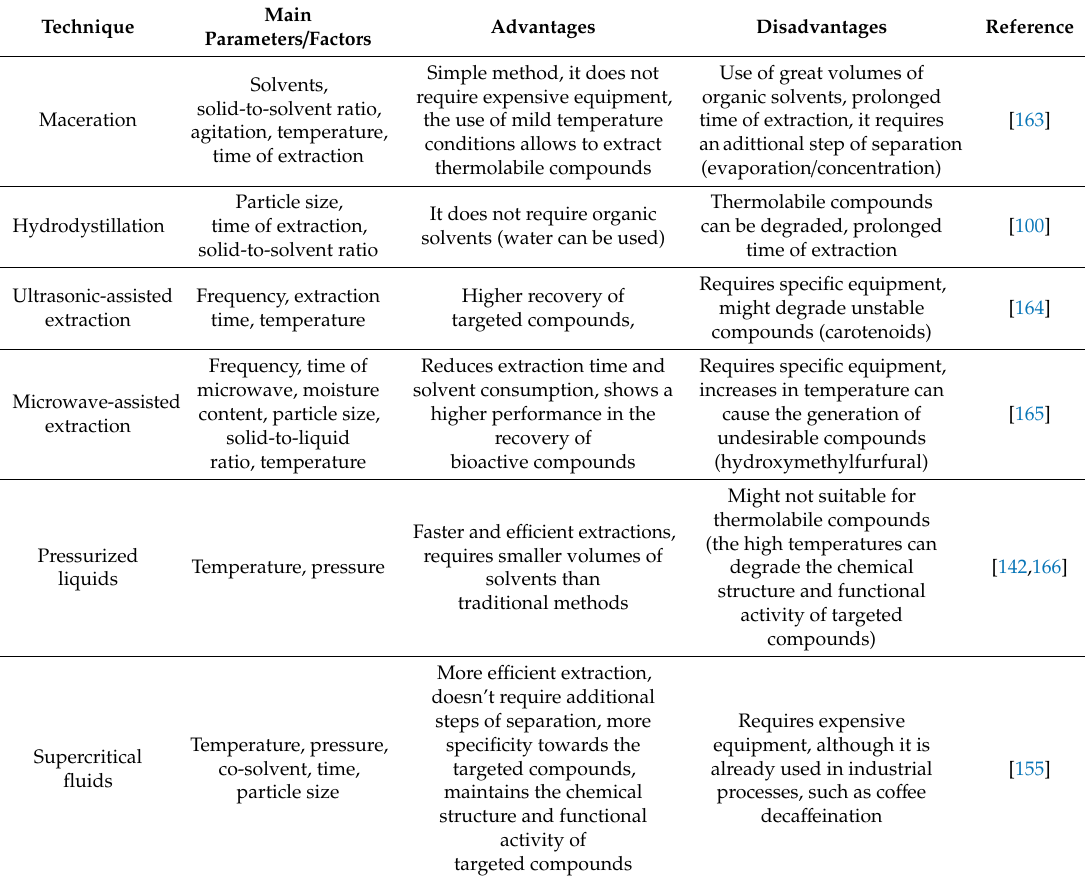
Table 3. Comparisson of extraction techniques for obtaining antioxidant